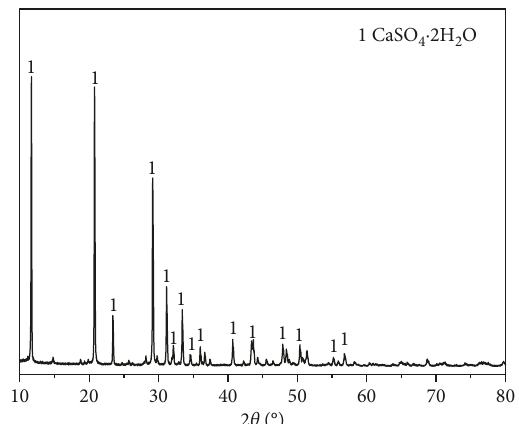
Figure 8: XRD pattern of hydration products of the OD/EP gypsum sample.